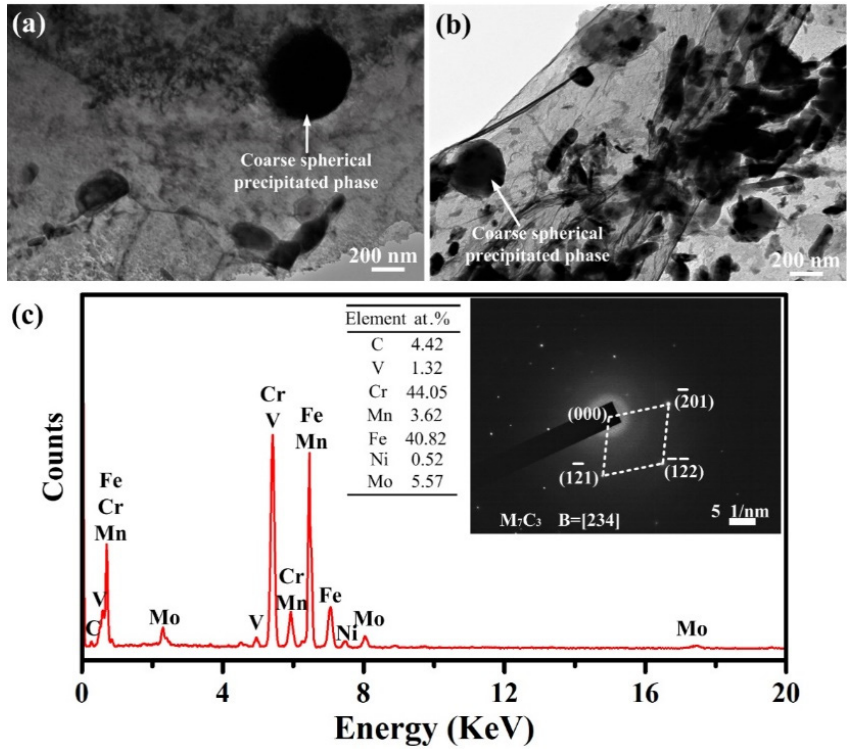
Figure 10. TEM analysis of BL and WM. ( a ) Bright-field image of BL. ( b ) Bright-field image of WM. ( c ) Coarse spherical carbide. ( d ) Carbide in ( c ) analyzed by SAEDP.